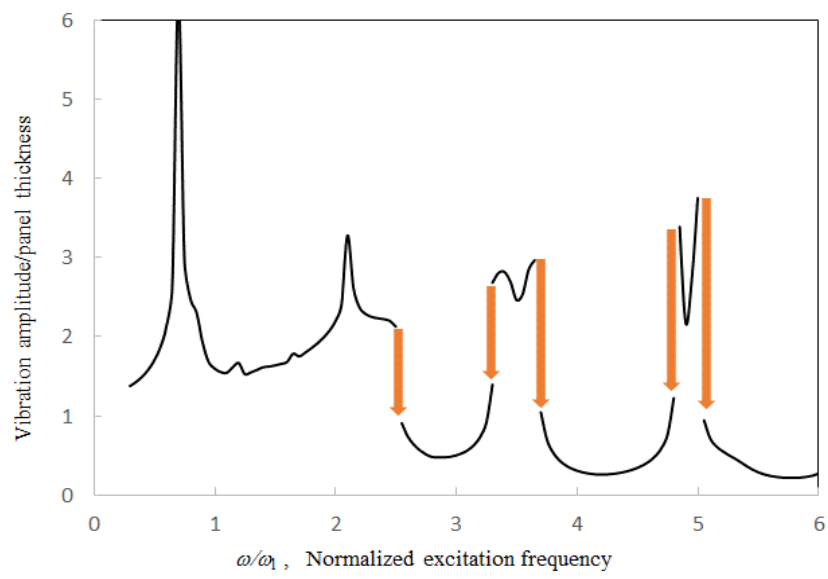
Figure 10. Vibration amplitude ratio versus normalized excitation frequency for various duct lengths (number of structural modes = 2, number of acoustic modes = 4, γ = 2, θ = 0, l = 10 a ; the orange arrows represent the “jump phenomenon”).